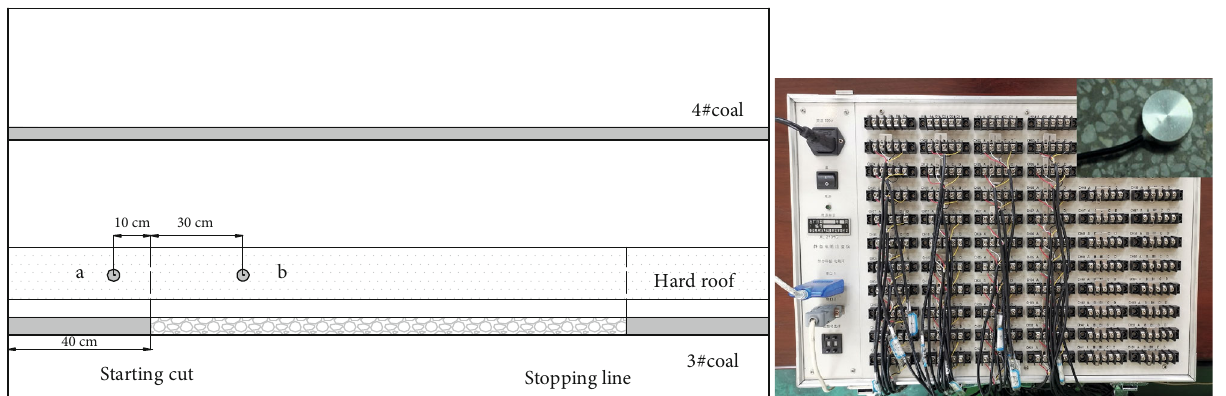
Figure 5: Physical analog model.